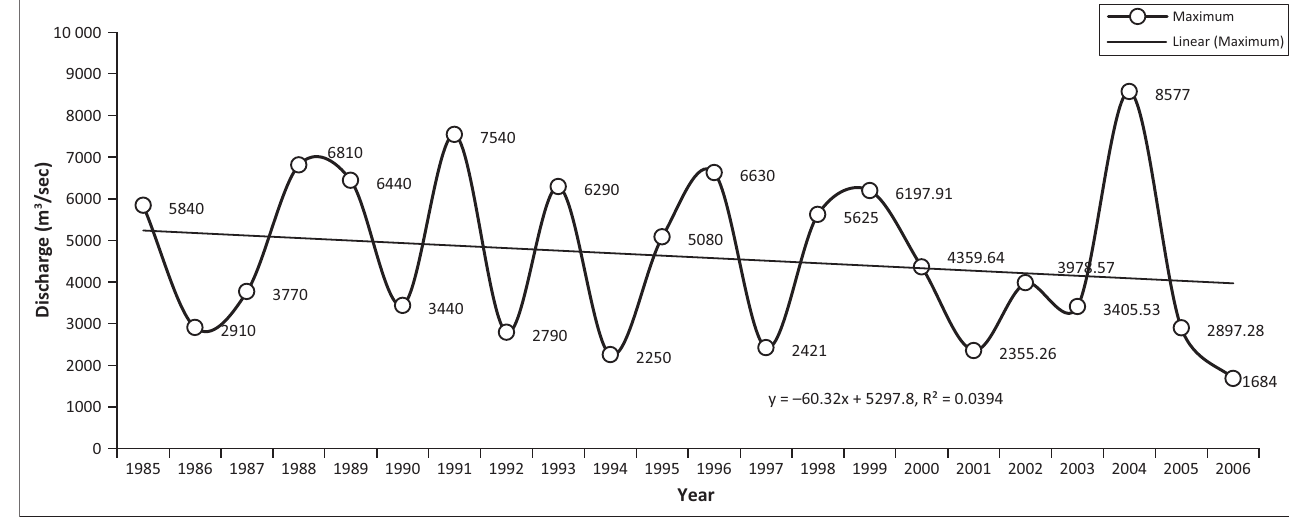
FIGURE 3: Yearly recorded monthly maximum discharge at Kaunia station from 1985 to 2006.